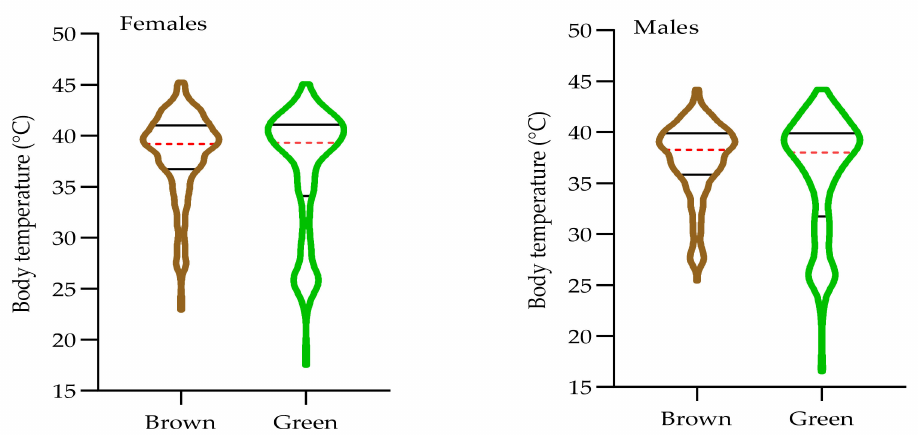
Figure 5. Violin plot of internal body temperature in different sexes of brown and green individuals of Oedaleus decorus